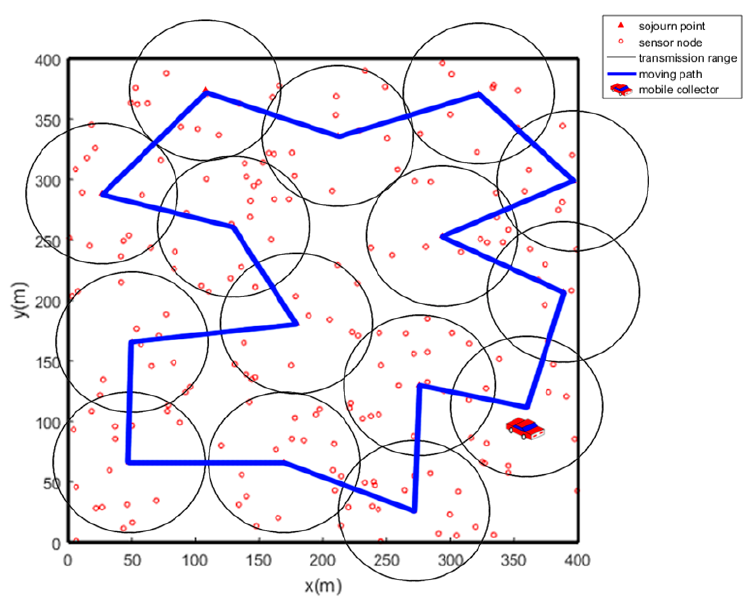
Figure 9. Path planning using ACO.